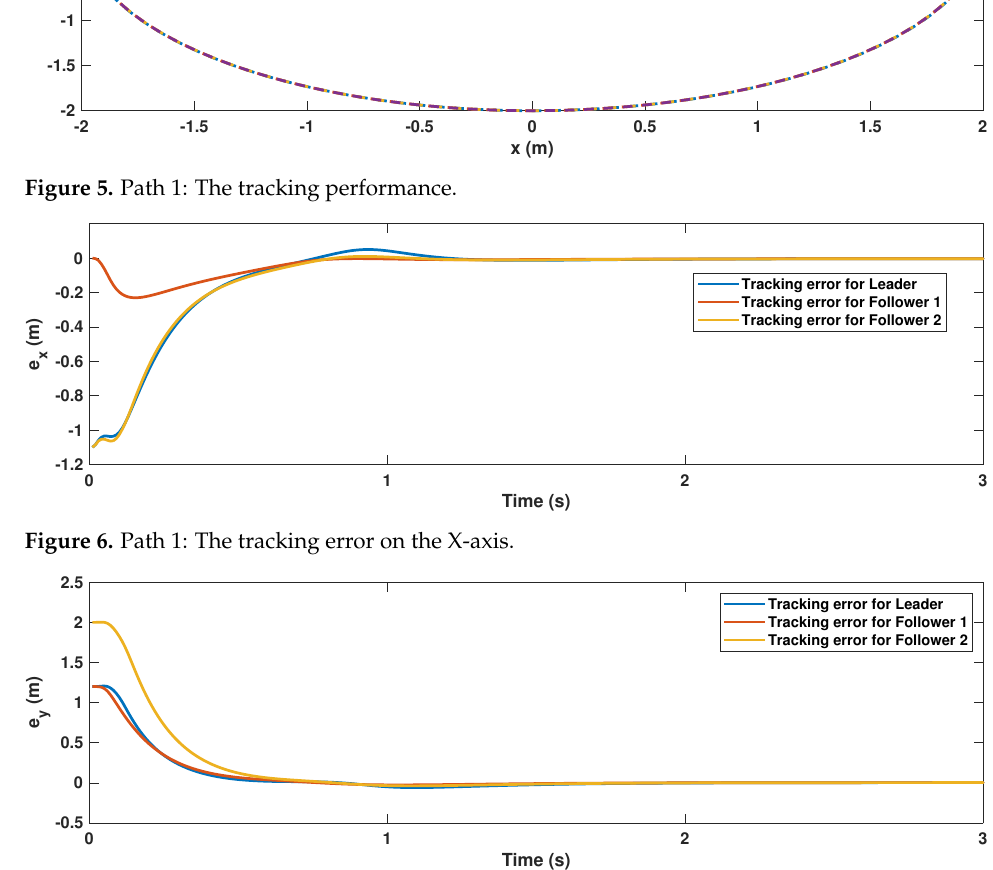
Figure 7. Path 1: The tracking error on the